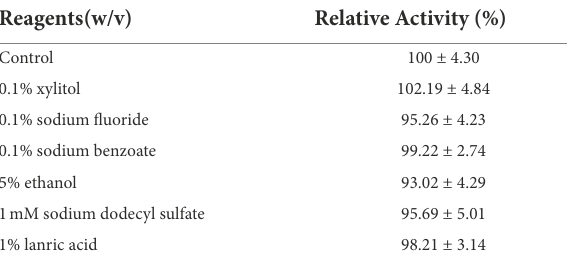
TABLE 2 Effects of dental caries chemical treatment reagents on CeDex.